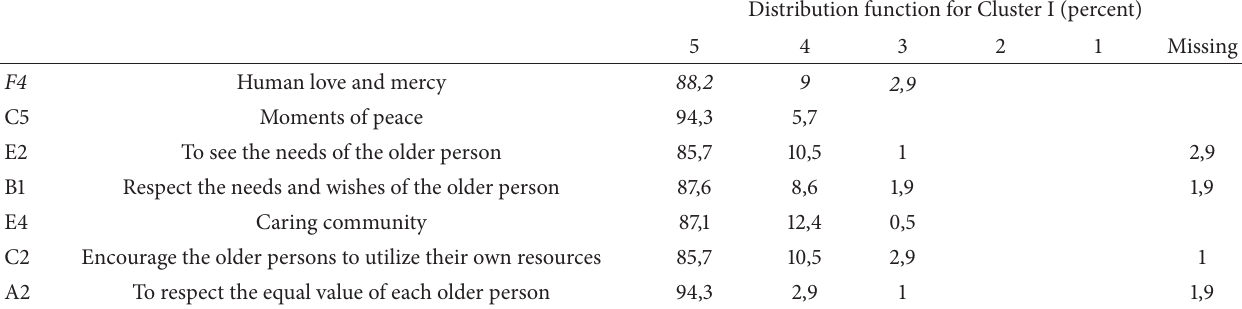
Table 1: Cluster I: